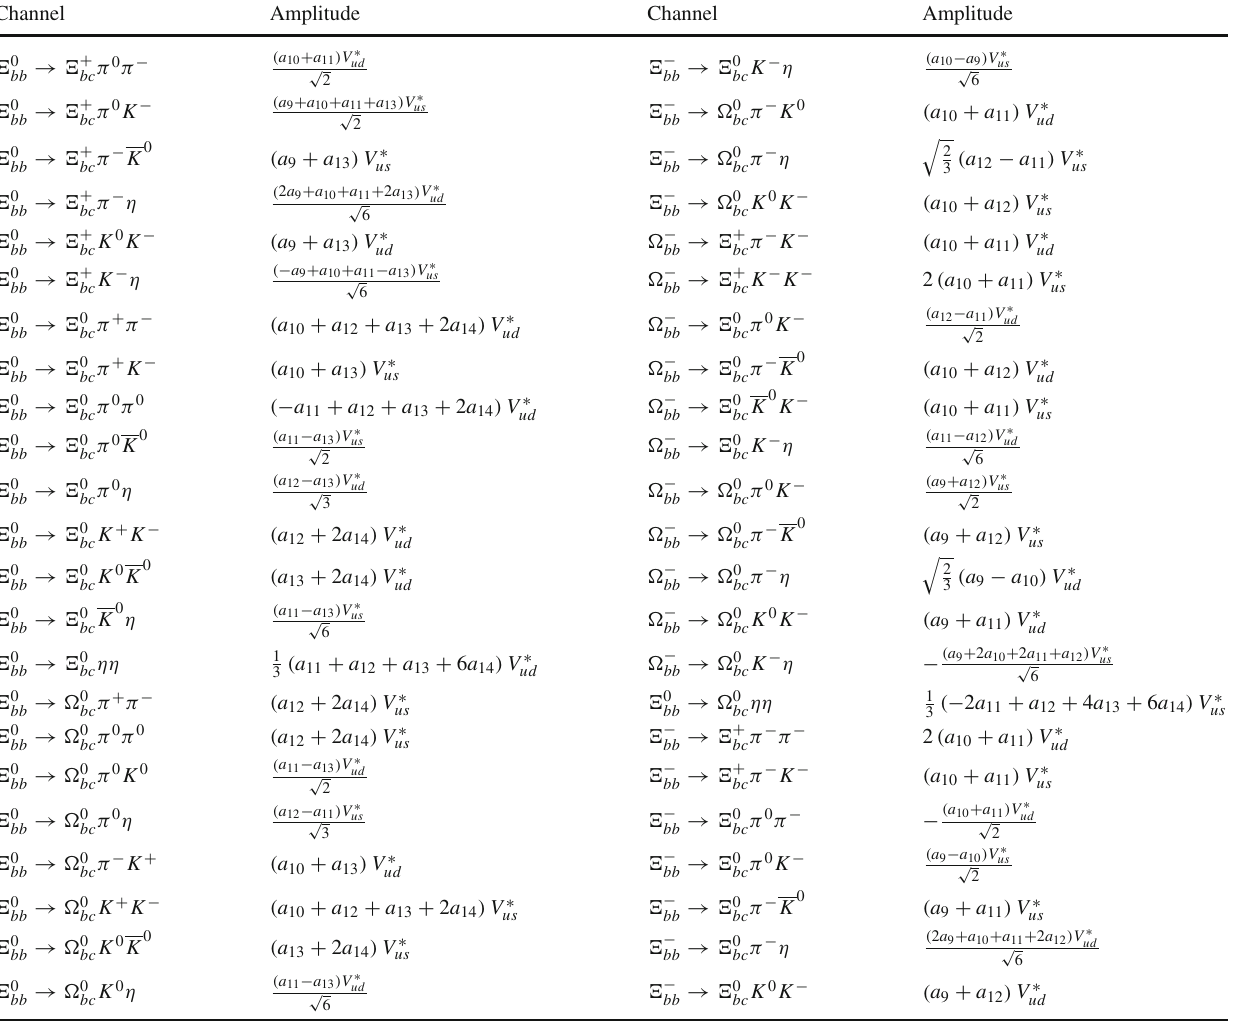
Table 17 Doubly bottom baryon decays into a bcq and two light mesons Channel Amplitude Channel